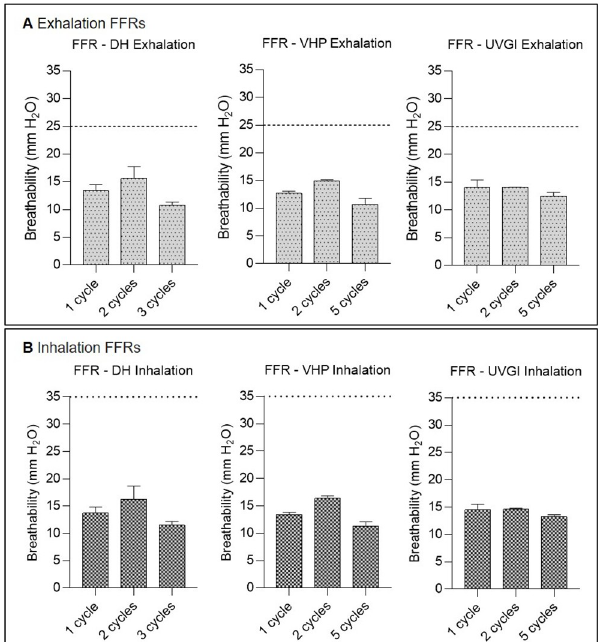
Fig 6. Filtering facepiece respirator (FFR) breathability testing after single-cycle or multiple-cycle decontamination using dry heat (DH), vaporised hydrogen peroxide (VHP), and ultraviolet germicidal irradiation (UVGI). Exhalation (A) and inhalation (B) breathing resistances after decontamination. Horizontal dashed (above) and dotted (below) lines represent the following breathing resistance standards: Exhalation: � 25 mmH 2 O and Inhalation: � 35 mmH 2 O for FFRs according to NIOSH 42 CFR Part 84. Untreated FFRs (n = 5) achieved inhalation and exhalation resistance of 12.43 ( ± 0.69) mmH 2 O and 11.9 ( ± 0.86) mmH 2 O, respectively.